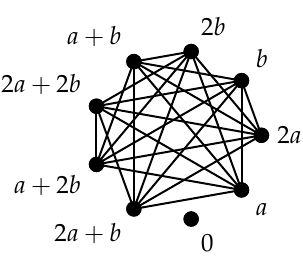
Figure 2. Γ a + b : r -noncommuting graph of E ( 4 ) when r = a + b . E ( 4 )